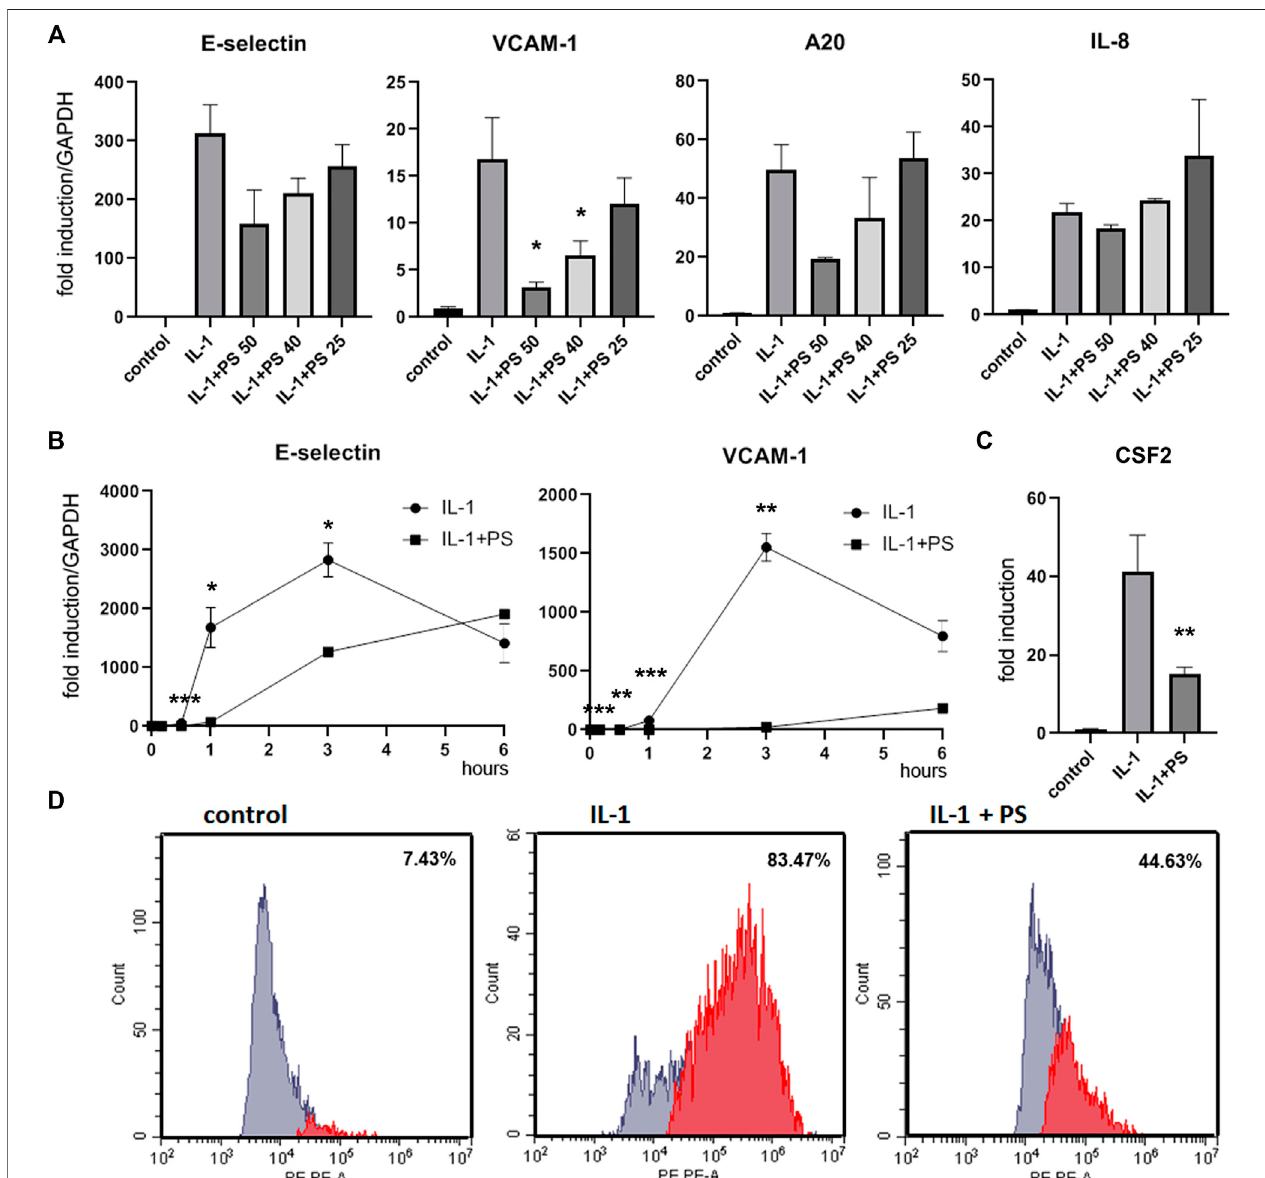
FIGURE1| PSsuppressestheexpressionofE-selectin,VCAM-1,A20,andCSF2,butnotIL-8. (A) HUVECwerepre-incubatedfor30 minwith50,40,and25 μ g/ ml PS, then stimulated with 5 ng/ml IL-1 for 2 h and analyzed for E-selectin, VCAM-1, A20, and IL-8 mRNA by qPCR. Relative mRNA levels were normalized to GAPDH and expression levels are depicted as mean fold change +/ − SD as compared to unstimulated control cells. (B) HUVEC were pretreated with 50 μ g/ml PS, then stimulated with IL-1 for the indicated times and analyzed for E-selectin and VCAM-1 as above. (C) HUVEC were pre-incubated for 30 min with 50 μ g/ml PS, then stimulated with 5 ng/ml IL-1 for 3 h, and supernatants analyzed for CSF2 by ELISA. (D) HUVEC were stimulated with 5 ng/ml IL-1 either alone for 3 h or after pre- treatment for 30 min with 50 μ g/ml PS, stained with PE-labelled anti-VCAM-1 antibody and analyzed by FACS. Percentages of VCAM-1 positive cells are given in